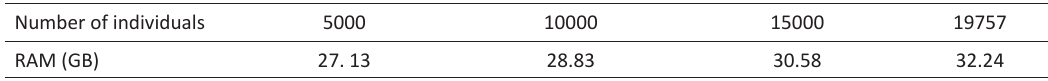
Table 7. Peak RAM use (in GB) for 46914 SNP markers and an increasing number of individuals from 5000 to 19757 Number of individuals 5000 RAM